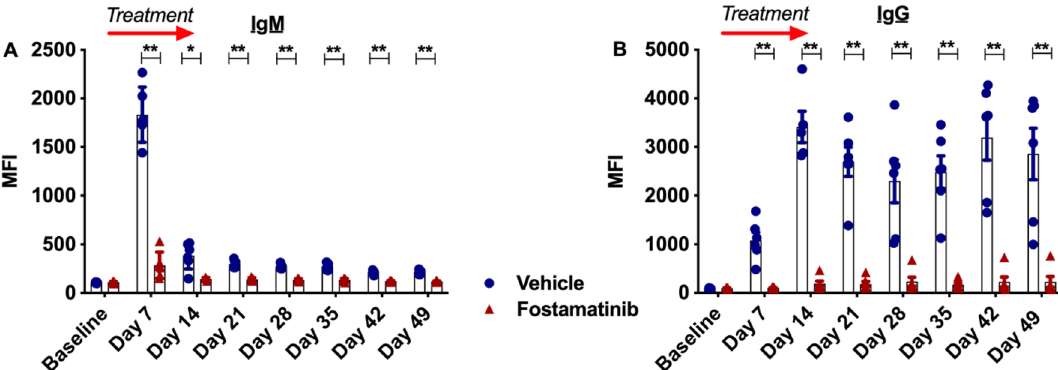
Figure 5. Fostamatinib prevents DSA production up to 5 weeks post completion of treatment. Treatment was given from day 1 to day 14 after blood transfusion. Then, the antibody levels were monitored until day 49. T lymphocyte crossmatch analysis was performed to detect DSA levels in sensitized fostamatinib and vehicle dosed LEW rats. ( A ) IgM and ( B ) IgG production was inhibited up to 5 weeks post-termination of the fostamatinib treatment regimen (n = 6 rats/group) (*P ≤ 0.05, **P ≤ 0.01). Blue filled circle—vehicle, red filled